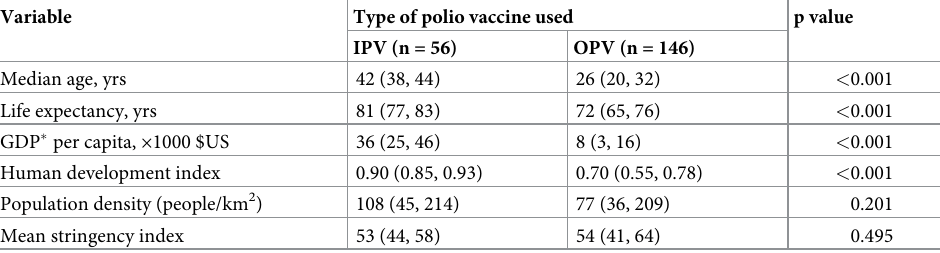
Table 1. Median (IQR) of studied continuous variables stratified by the type of polio vaccine used.